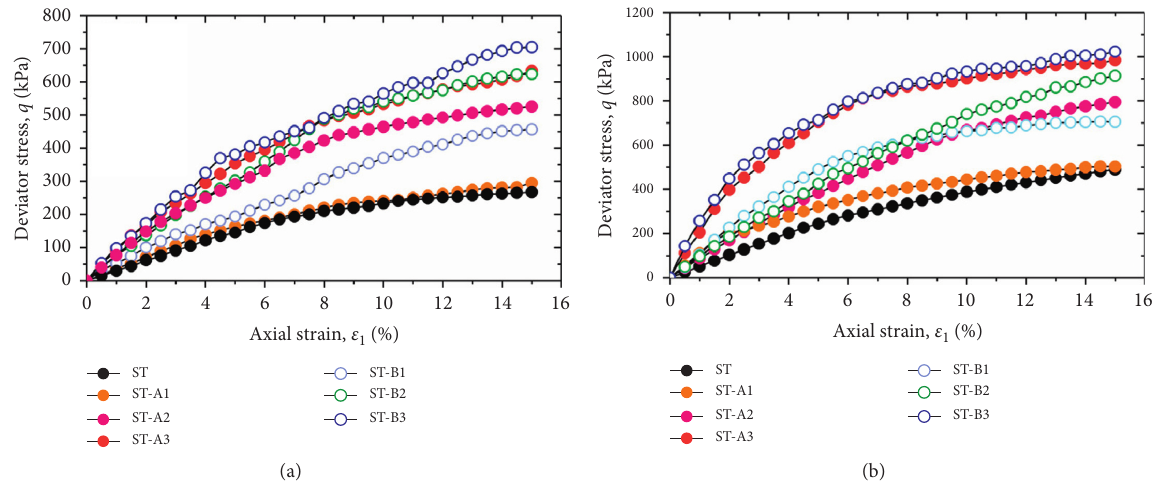
Figure 8: Effects of filling material content on the stress-axial strain curves for various controlled net confining pressures: (a) σ and (b) σ 3 – u a �